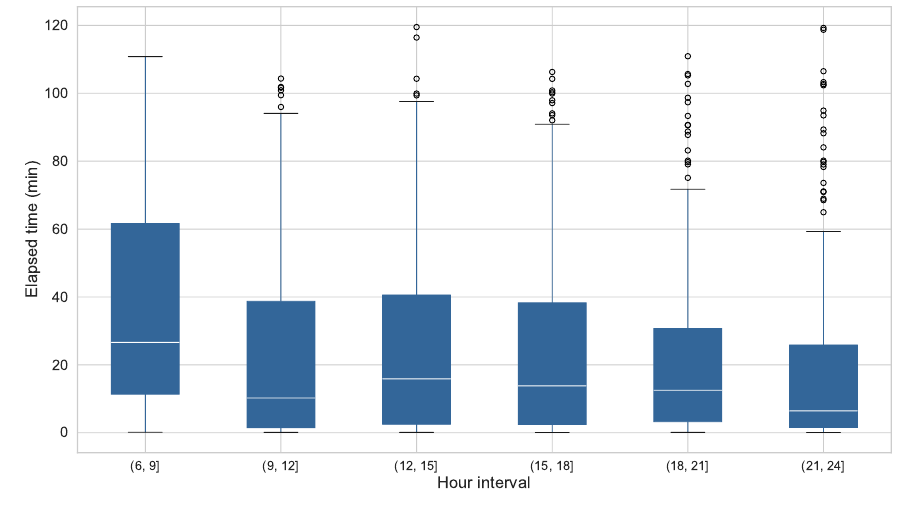
Figure 11. Time elapsed from the reception of the notification to the participant’s response per interval of daily